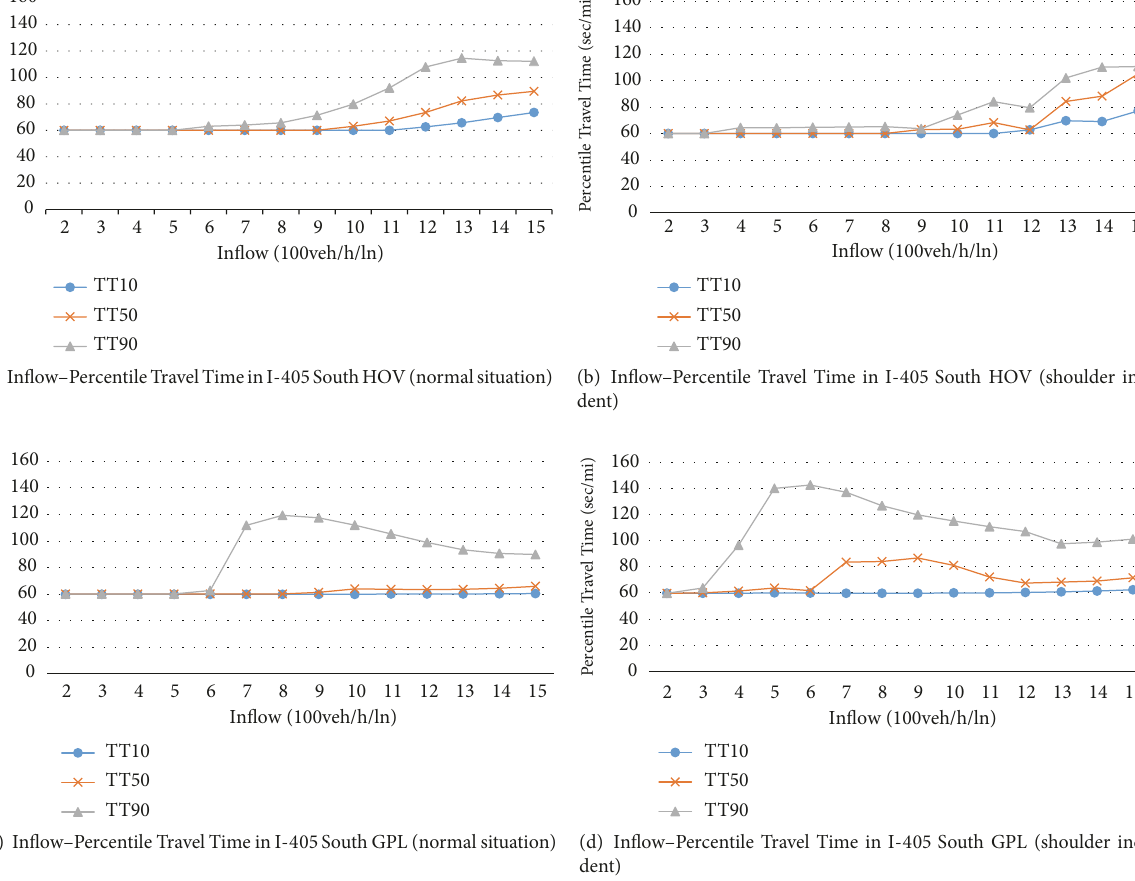
Figure 6: Inflow–Percentile traveltime function in I-405 South under normal situation and shoulder incident. (a) I-405 South HOV (normal situation). (b) I-405 South HOV (shoulder incident). (c) I-405 South GPL (normal situation). (d) I-405 South GPL (shoulder